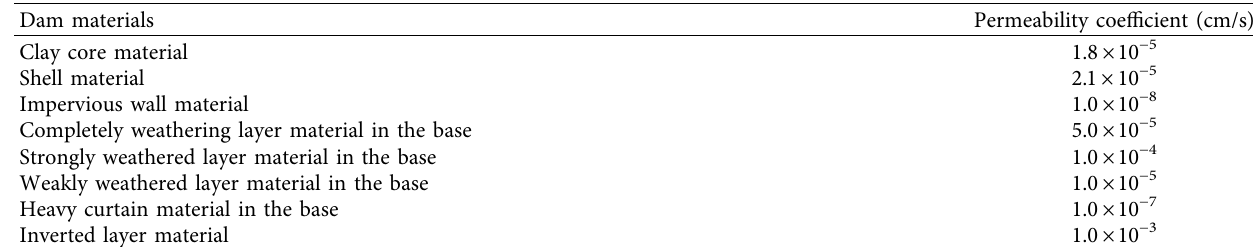
Figure 4: Photos of site sampling: (a) well drilling; (b) sampling; (c) specimen. Table 1: Permeability coefficient of different materials of the